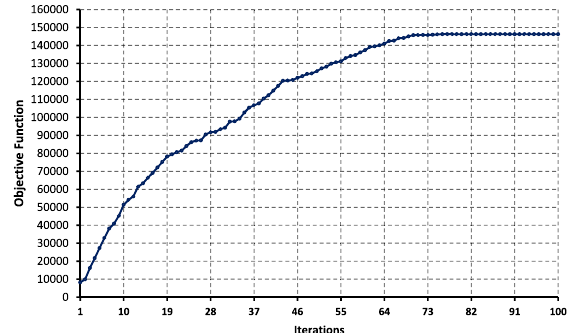
Fig. 11 GA convergence diagram